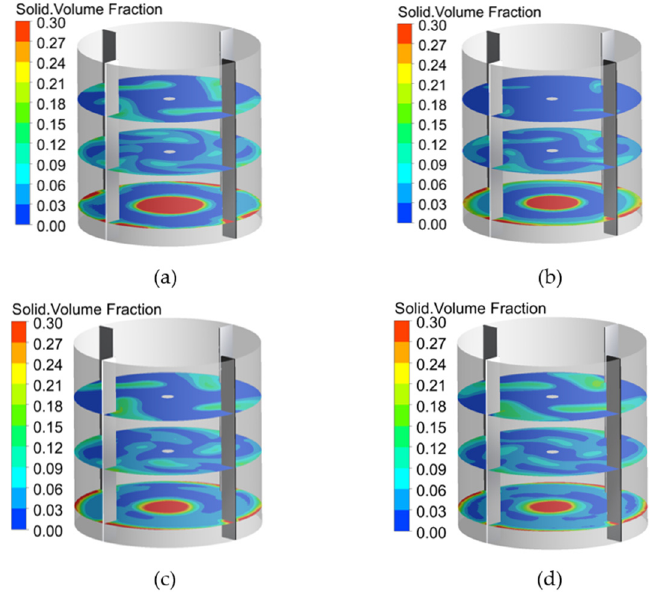
Figure 11. Contour plots of the solid volume fraction on horizontal planes at different vessel heights